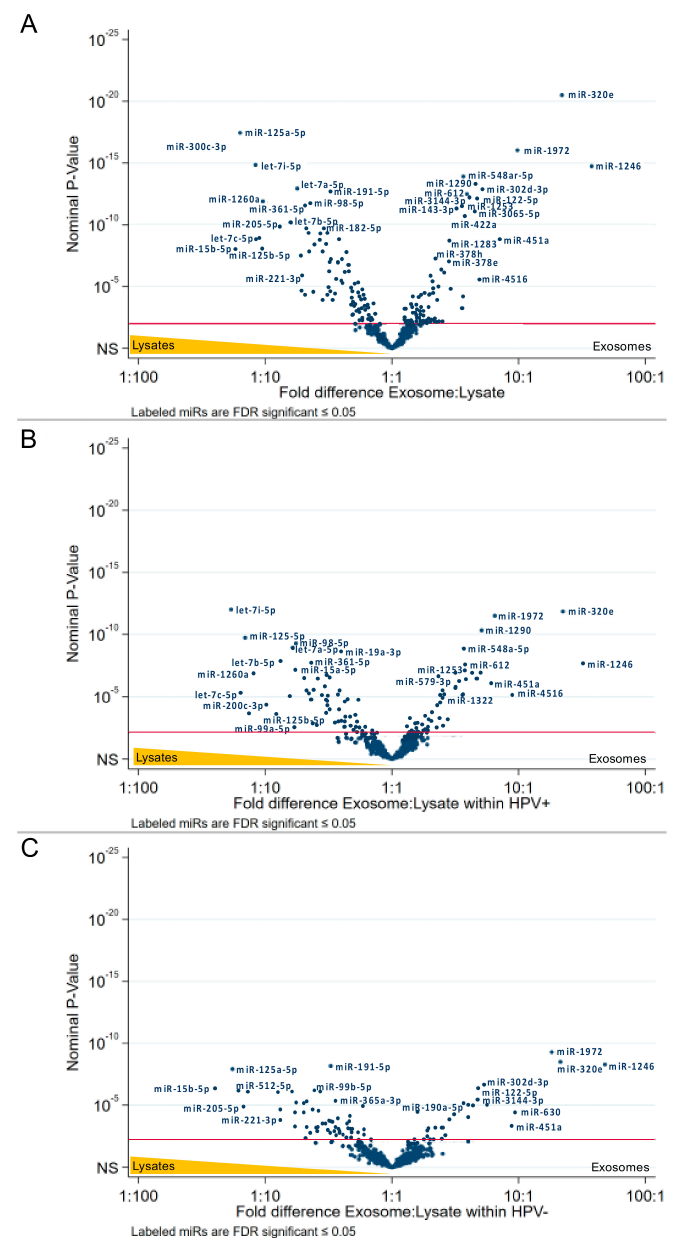
Figure 4. Volcano plot analysis of miRs according to their localization in exosomes and / or cell lysates. Relative expression levels of miRs are presented in fold di ff erences exosomes:lysates as blue spots (horizontal axis). The three di ff erent graphs visualize all ( A ), HPV( + ) ( B ) and HPV( − ) ( C ) miRs. Dots at the right upper side are much more expressed in exosomes than in lysates, while dots at the left upper side are far more expressed in lysates than in exosomes. The vertical axis represents the significance level of the False discovery rate. p -value ≤ 0.05 are considered to be significant (red